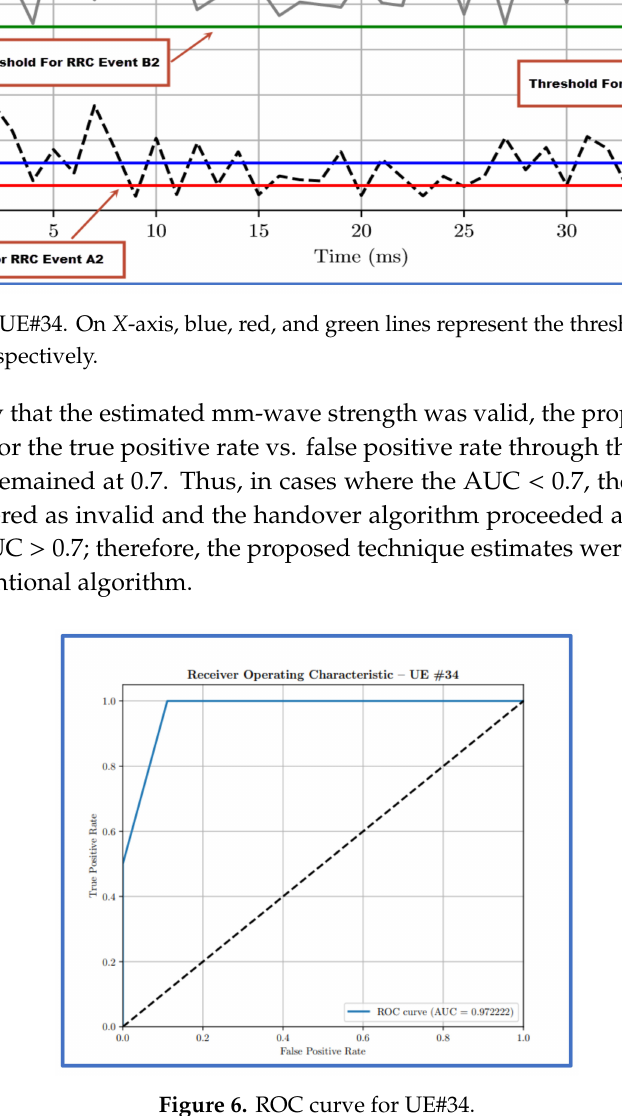
Figure 6. ROC curve for